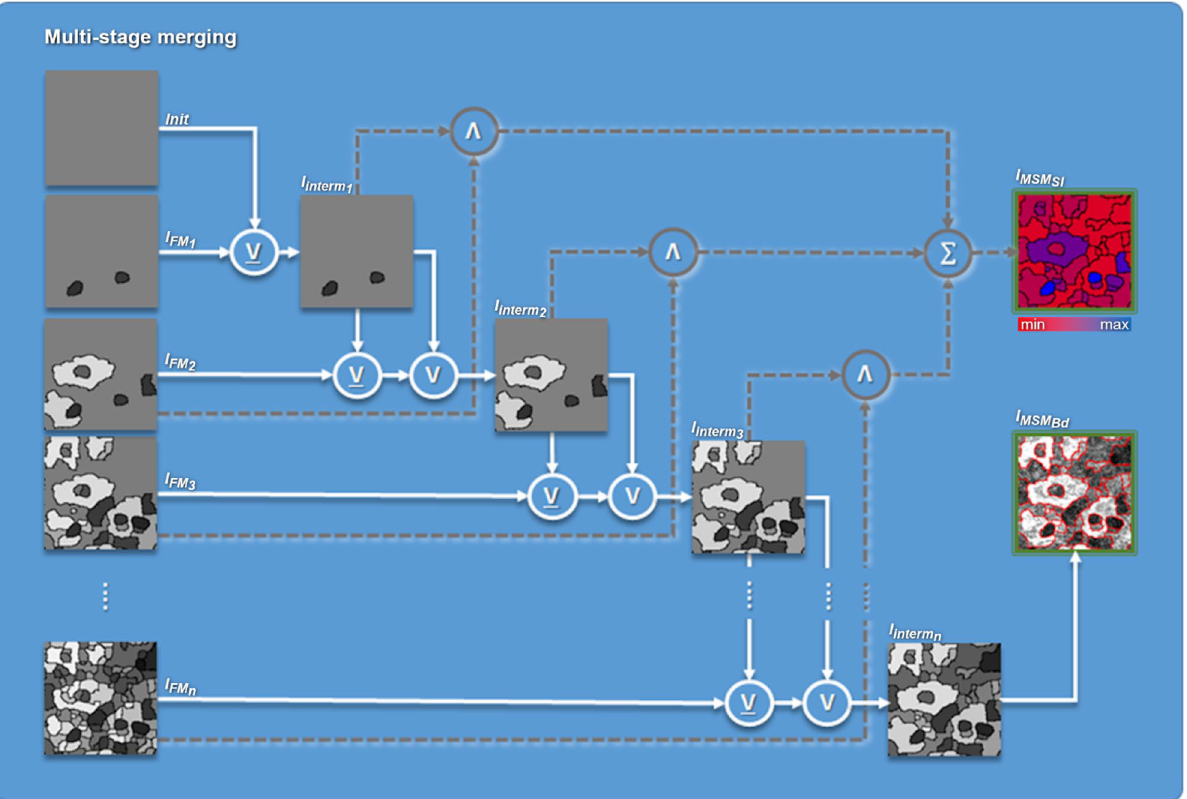
Figure 3. Multi-stage merging. Iterative process of merging using logical operation exclusive disjunction ( ⊻ ) and disjunction ( ∨ ) of initial segments (blue) stability index) by overall summation of iterative conjunction ( ∧ ) of binarized